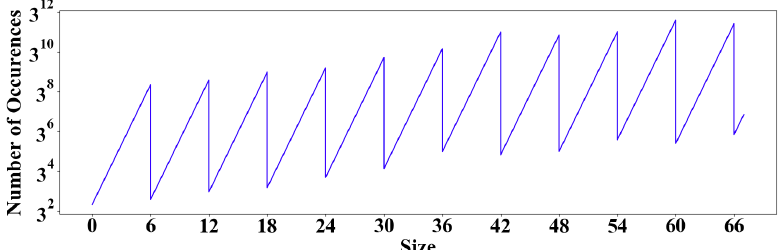
Figure 8: Size Distribution of Block Candidates in the HIDCPA Recursive